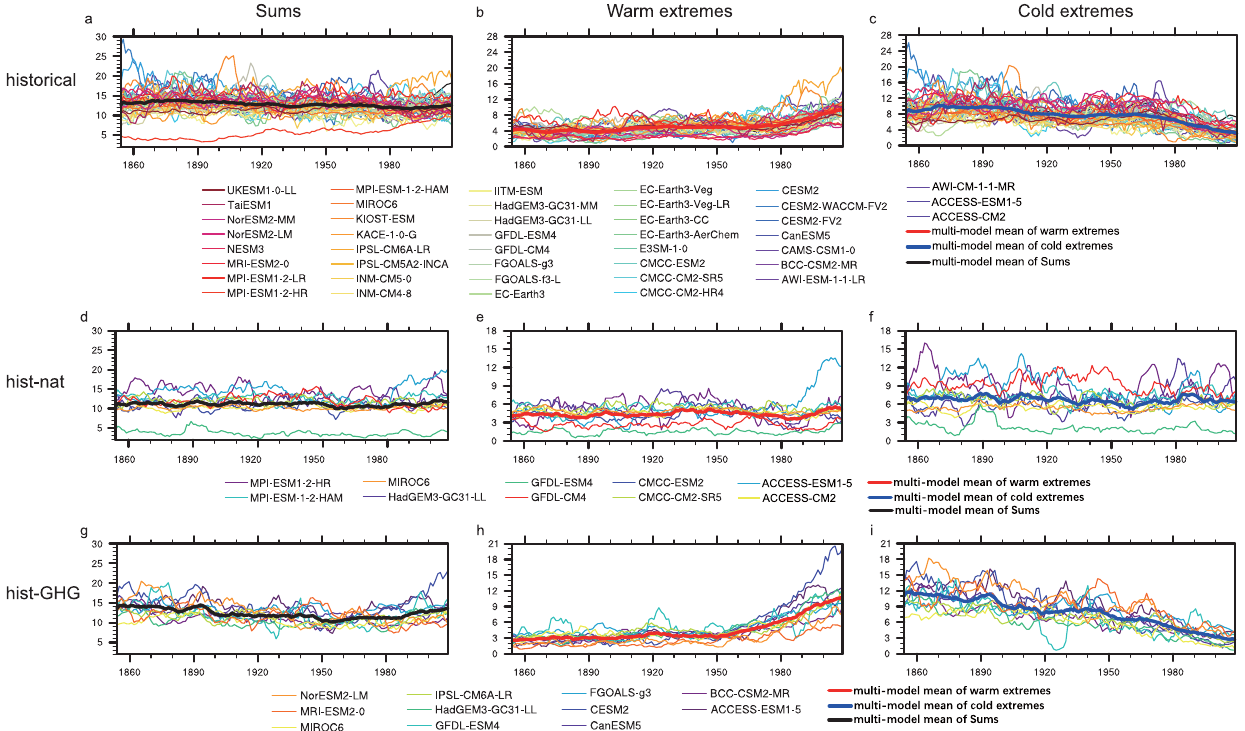
Fig. 2 Decadal variations in the SAT extremes over Siberia in winter based on the CMIP6 simulations. a Decadal variations in the Sums ( a , d , g ), warm extremes ( b , e , h ) and cold extremes ( c , f , i ) over Siberia in winter during 1850 – 2014 based on D1 (units: days season − 1 ) for each model in the historical ( a , b , c ), hist-nat ( d , e , f ) and hist-GHG runs ( g , h , i ). The black, red and blue thick lines are the multi-model means of the Sums, warm extremes and cold extremes, respectively. The x-axes are for years, and the y-axes are for the frequencies of the Sums, warm extremes and cold extremes (units: days season − 1